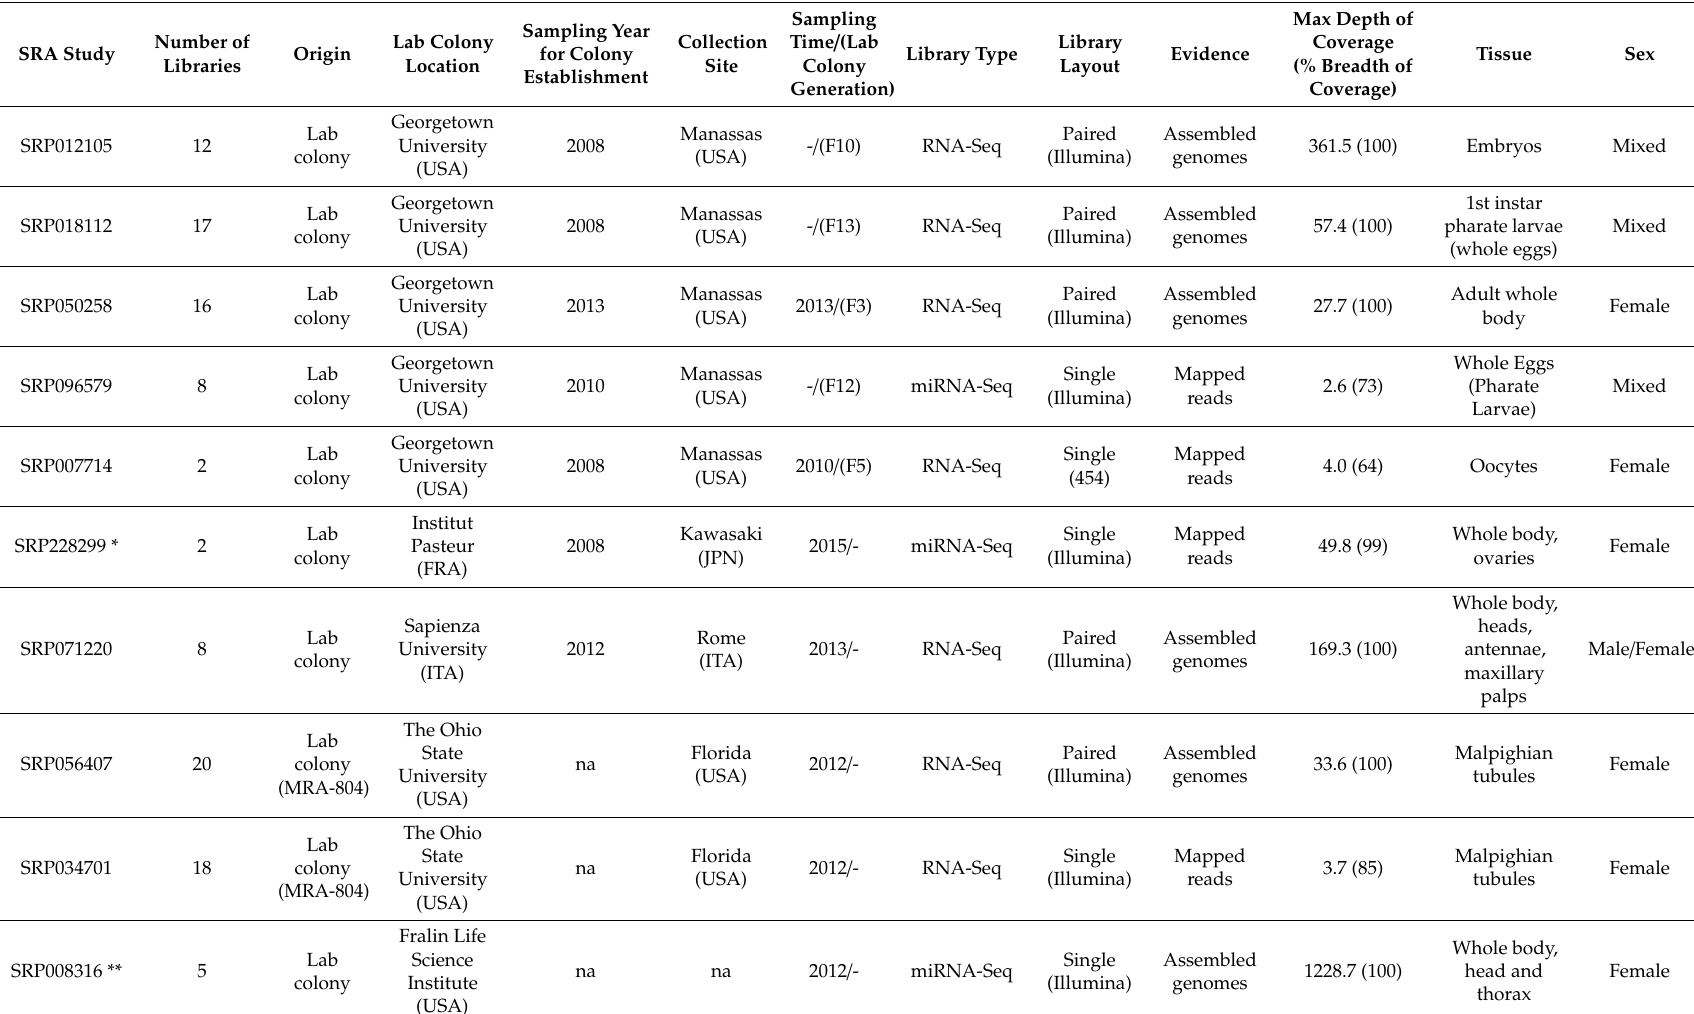
Table 1. Details of the Ae. albopictus RNA-Seq and miRNA-Seq libraries in which AealbAV was